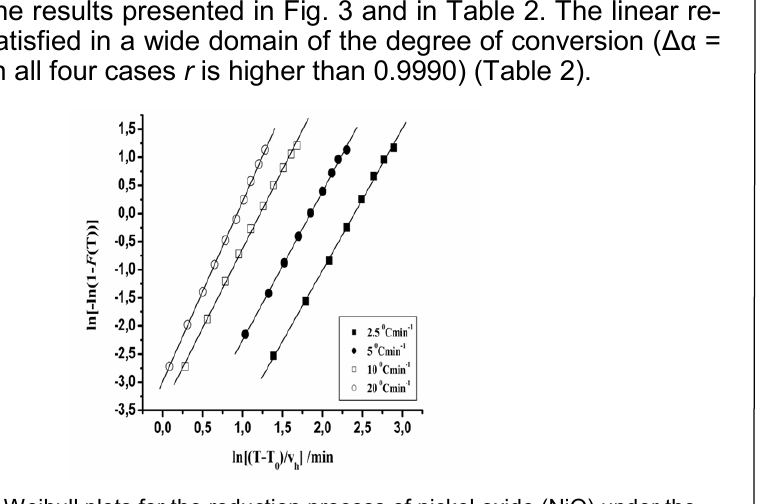
Figure 3 – The Weibull plots for the reduction process of nickel oxide (NiO) under the hydrogen atmosphere at different heating rates (v h ): 2.5 0 Cmin -1 ( ■ ), 5 0 Cmin -1 ( ● ), 10 0 Cmin -1 ( □ ), 20 0 Cmin -1 ( ○ ) Slika 3 – Vejbulovi grafici za proces redukcije nikl-oksida (NiO) pod atmosferom vodonika na razli č itim brzinama zagrevanja (v h ): 2,5 0 C min -1 ( ■ ), 5 0 C min -1 ( ● ), 10 0 C min -1 ( □ ),20 0 Cmin -1 ( ○ ) Table 2 – The linear domains of α ( ∆α ), the rate constants (1/ η ) and the Weibull distribu- tion parameters ( β and η ) with γ equal to zero, obtained for the reduction process of NiO using hydrogen at different heating rates, with the corresponding values of r and SD Tabela 2 – Linearni domeni α ( ∆α ), konstante brzina (1/ η ) i parametri Vejbulove raspode- le ( β and η ) sa γ jednako nuli, dobijeni za proces redukcije NiO koriš ć enjem vodonika na razli č itim brzinama zagrevanja, sa odgovaraju ć im vrednostima r i SD v h 1/ η ∆α / 0 Cmin -1